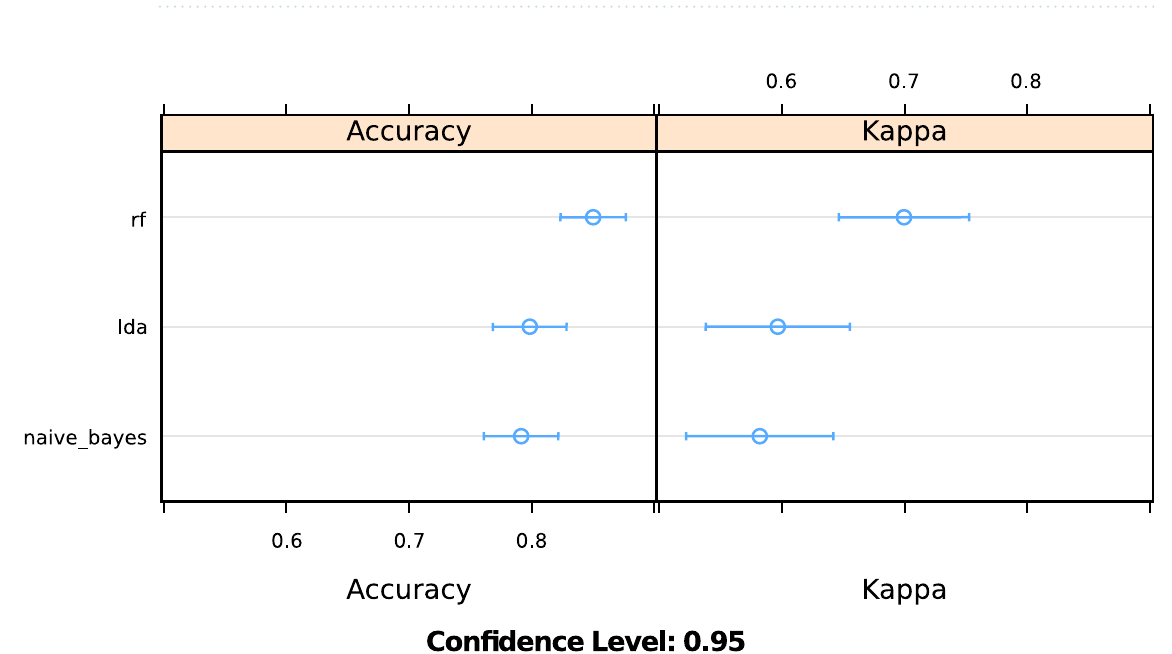
Table 5. Prediction performance of base classifiers and stacked ensemble.